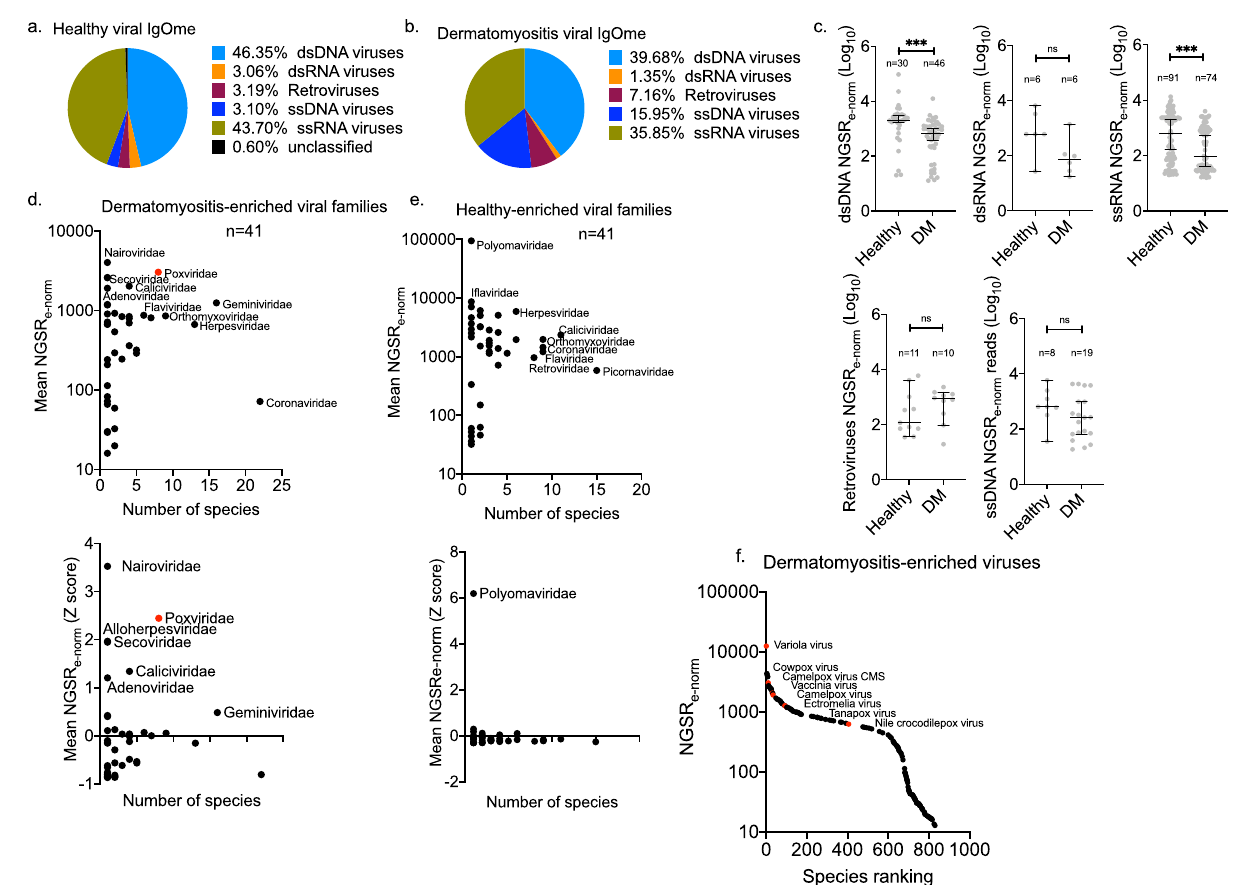
Fig. 4 The dermatomyositis-associated viral IgOme. Viral species were grouped based on genome type into six groups. The contribution of each viral group to the total NGSR e-norm output was evaluated in a healthy control (HC) P20 and b dermatomyositis (DM) P20. c Scatter plots of viral normalised abundance, mean NGSRe-norm, in DM and HC. Viruses are grouped based on their genome type. Scatter plots of viral family richness (number of species per family) and mean NGSRe-norm in: d DM, and e HC; in the upper panel NGSR e-norm values are depicted. In the lower panel, the NGSR e-norm values are Z transformed to identify viral targets with high NGSR e-norm (outliers). The Poxviridae viral family is depicted with red colour. f Scatter plot of species ranking based on NGSRe-norm in DM; species of the Poxviridae family are depicted with red colour. Differences were signi fi cant at the 0.05 level; * for p < 0.05, ** for p < 0.01, *** for p < 0.001. The median with 95% CI is